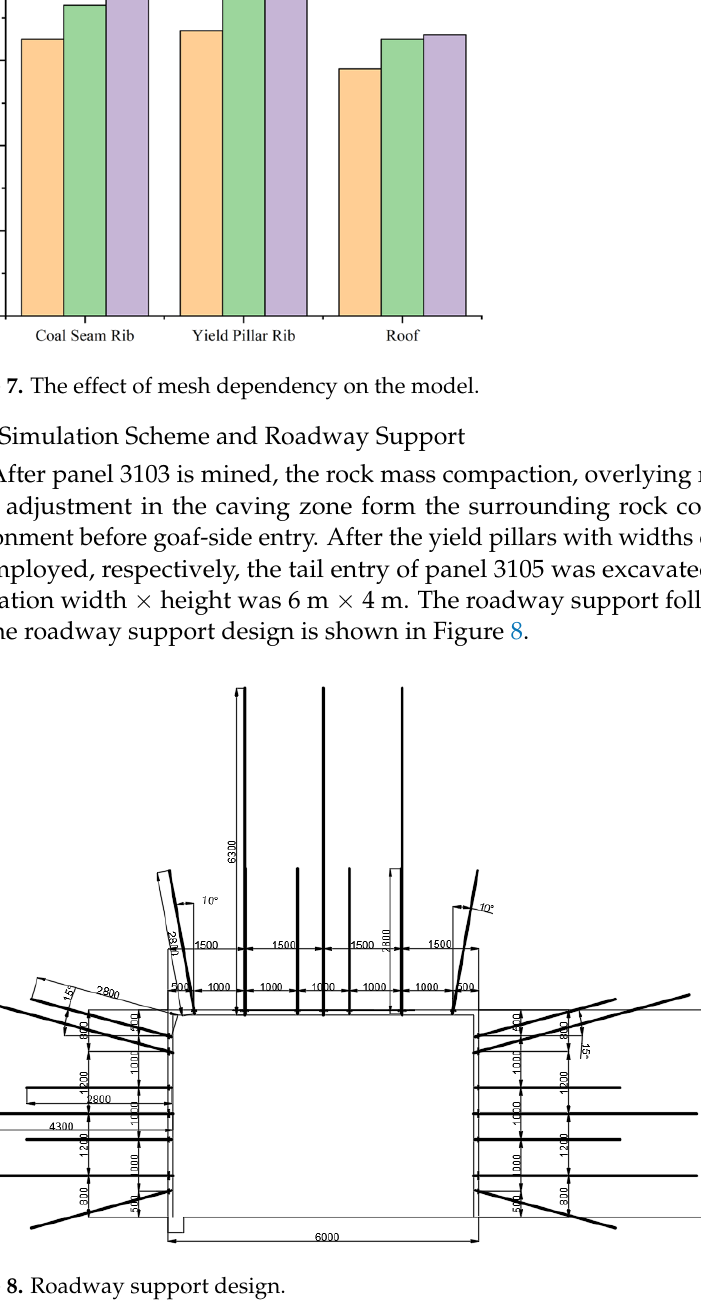
Figure 9. Roadway support design simulation.